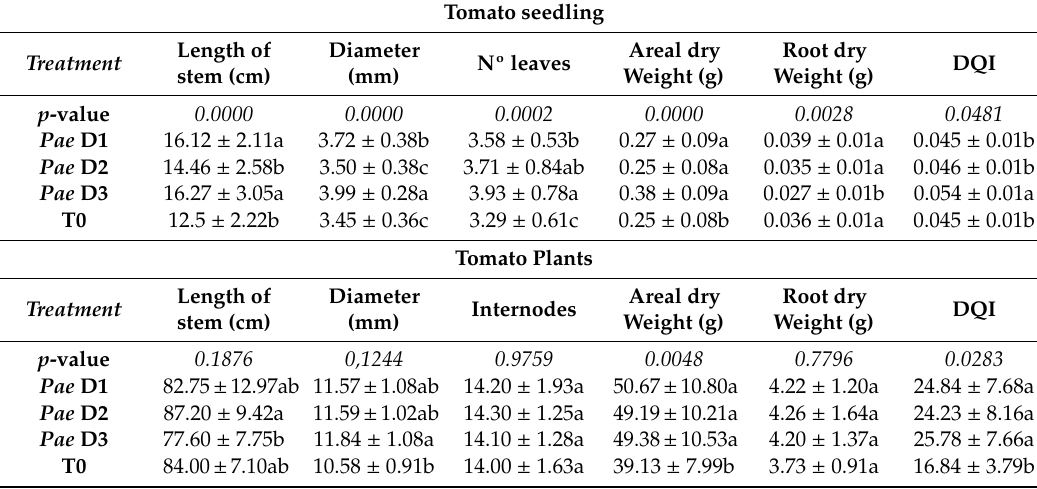
T0: control without P. variotii. Di ff erent letters indicate significant di ff erences according to the one-way ANOVA test ( p = 0.05). Treatment means were compared according to the Fisher’s LSD statistical procedure ( F -test at p <